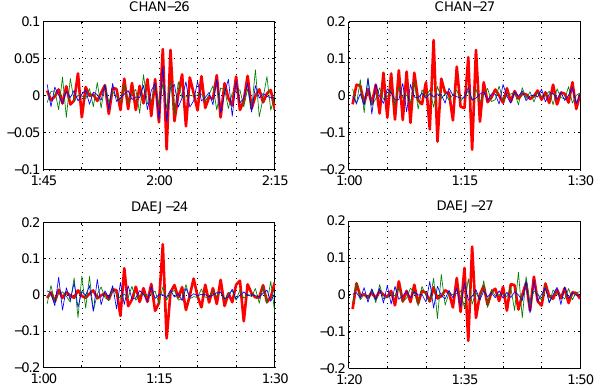
Figure 5. The extracted disturbance series containing the high- frequency TIDs at different stations for 3-day data. The abscissa represents the UT time and the ordinate represents the disturbance series with unit of TECU. The title for every panel is composed of station ID and satellite PRN number. The bold red line indicates the series on event day and the green and blue for the former day and the latter day, respectively.